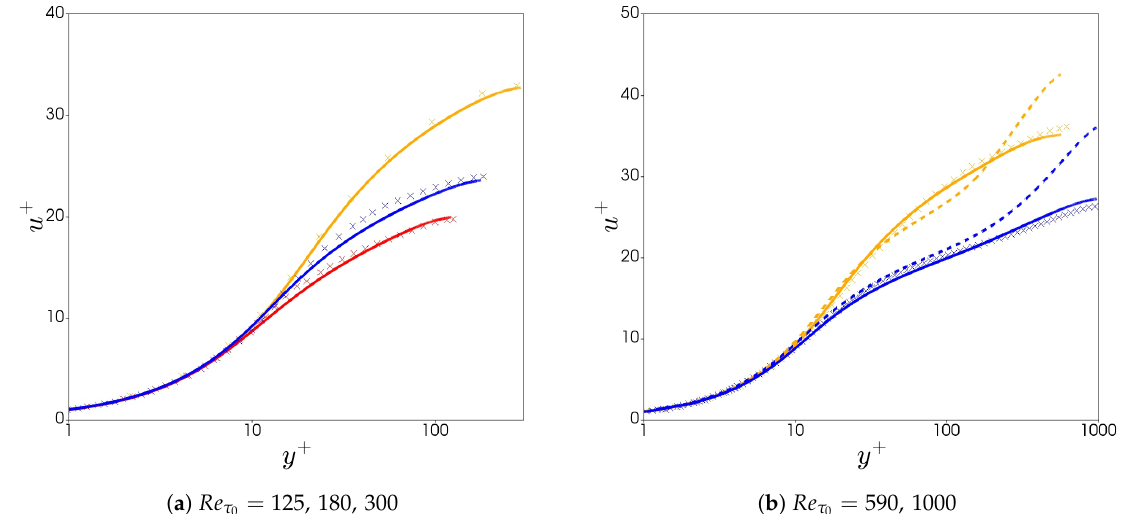
Figure 7. Comparison of the velocity profiles between DNS data ( × crosses), current model predictions (continuum lines) and previous model predictions [32] (dashed lines). Each colour represents a different drag reduction regime: ( a ) red (LDR case 1); blue (IDR case 10); orange (very HDR case 15). ( b ) blue (IDR case 27); orange (very HDR case